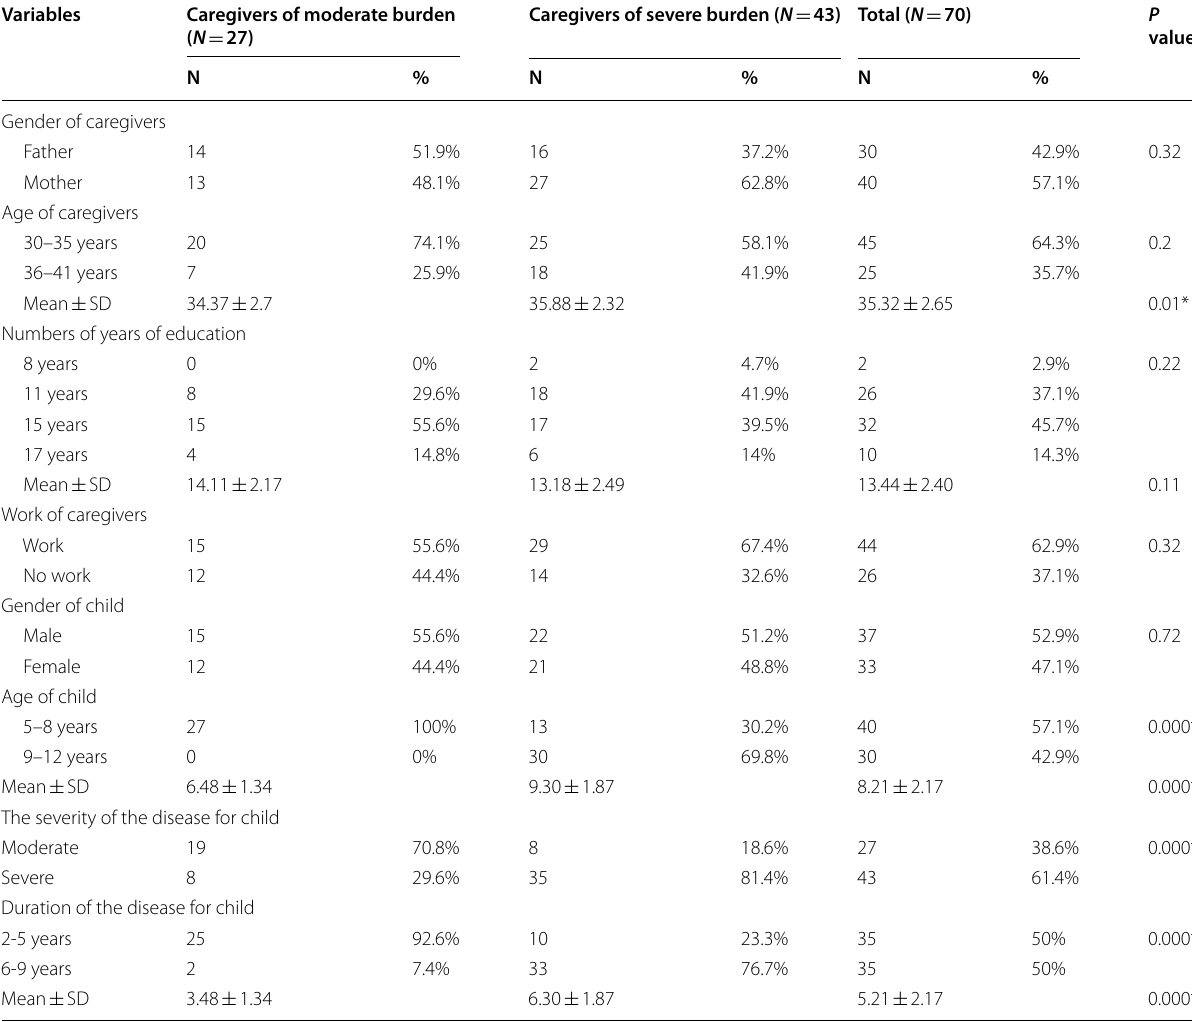
Chi squared test * Significant P value <